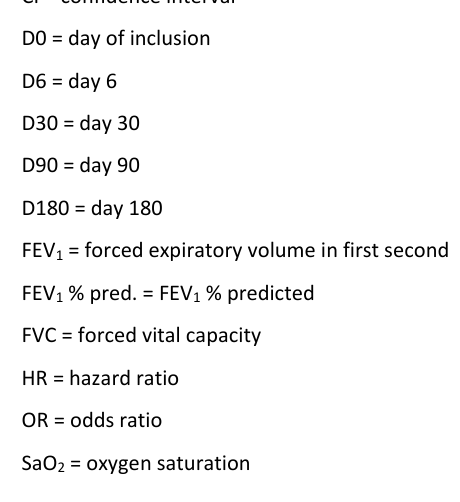
Table S1: Characteristics of quantitative variables.